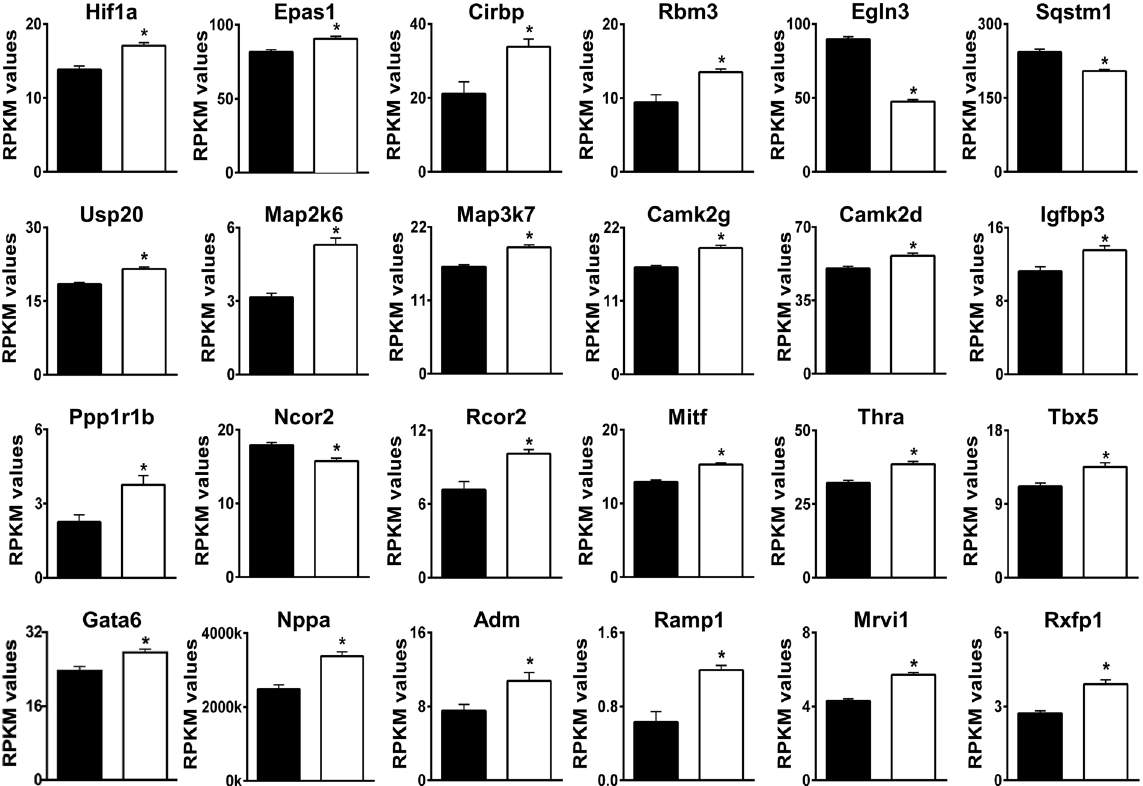
Figure 1. Differential expression of genes involved in hypoxia responses and vasodilation. Relevant genes were identified by Gene Ontology analyses and/or by PubMatrix analyses of genes with an FDR < 0.05. RPKM (Reads Per Kilobase of transcript per Million mapped reads) values for WT (black bars) and AE3-null (white bars) hearts are shown. The genes shown are a subset of 143 genes in Supplementary Table S2 and in a subset of 158 signaling genes in Supplementary Table S3; values are means ± SE; n = 4 for each genotype; * p ≤ 0.01 vs WT